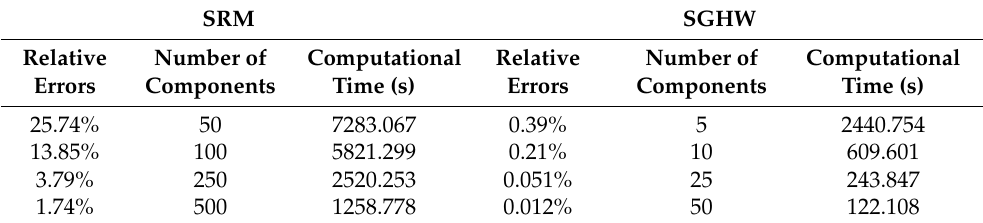
Table 1. Comparations of relative errors, number of components, and computational times between the SRM and SGHW method. SRM SGHW